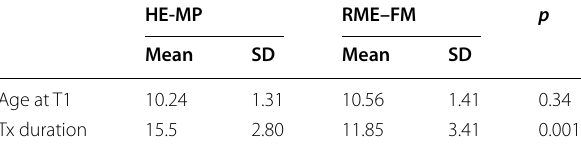
Table 1 Age and treatment duration in years for both groups